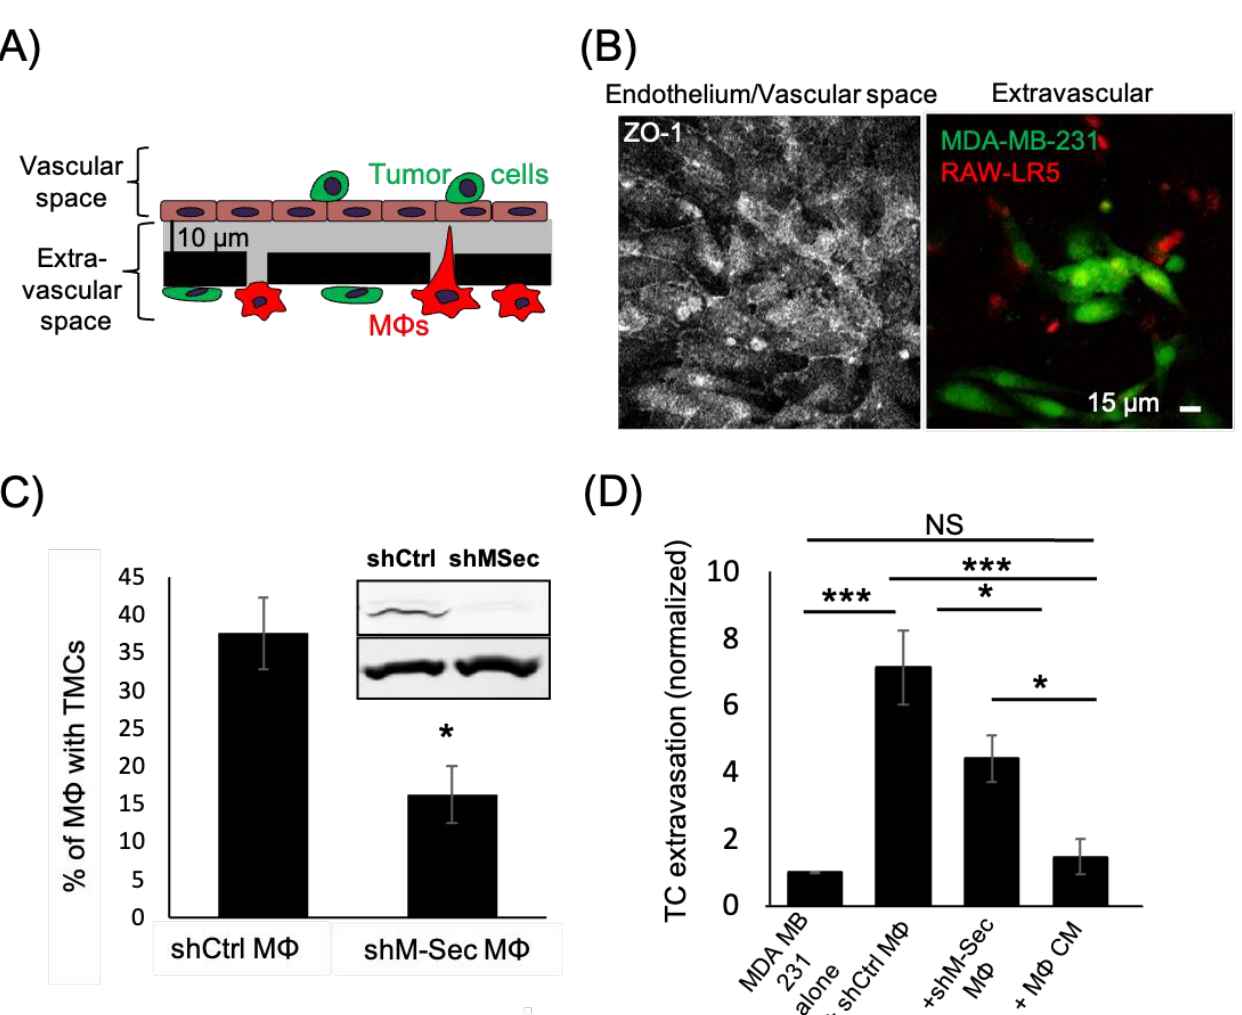
Figure 3. Macrophages defective in TMCs do not promote tumor cell extravasation . ( A ) Schematic representation of eTEM assay after overnight incubation to allow for maximal tumor cell